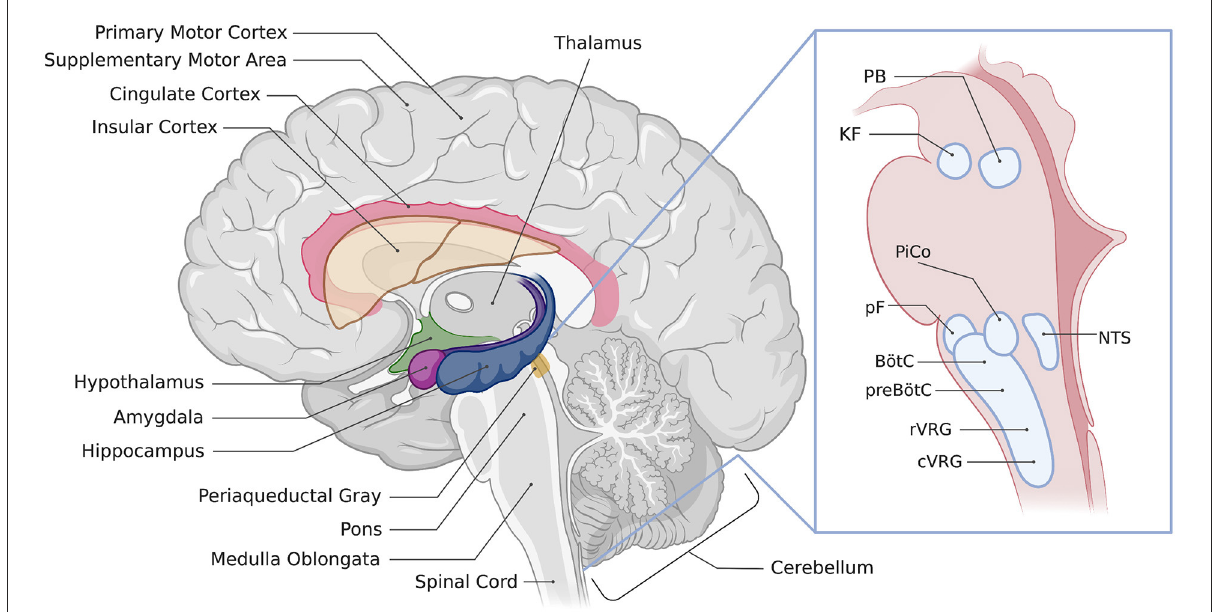
FIGURE1 Location of regions involved in the control of breathing. Illustration of a sagittal section of the human brain showing the approximate location of respiratory-associated brain regions discussed in the text. The inset image shows brainstem respiratory regions, PAG, periaqueductal gray; PB, parabrachial nuclei; KF, Kölliker-Fuse nucleus; PiCo, post-inspiratory complex; pF, parafacial respiratory groups; NTS, nucleus of the solitary tract, BötC, Bötzinger complex; preBötC, preBötzinger complex; rVRG, rostral ventral respiratory group; cVRG, caudal ventral respiratory group. Created with